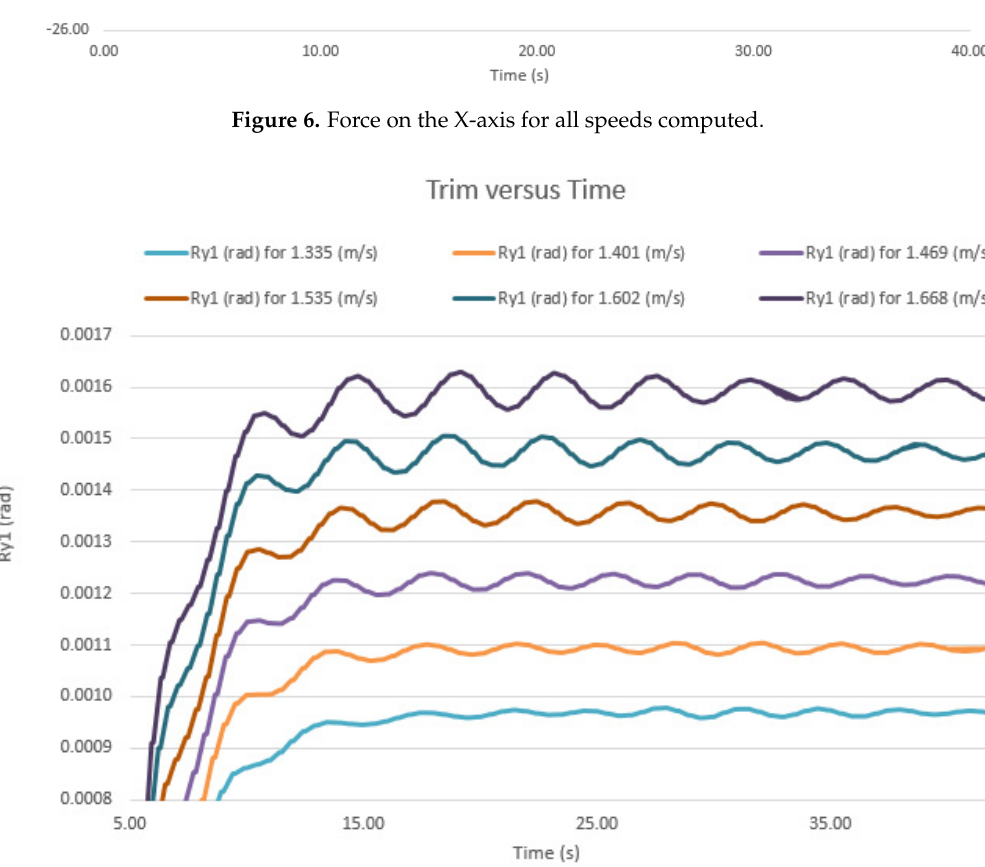
Figure 7. Trim for all speeds computed.